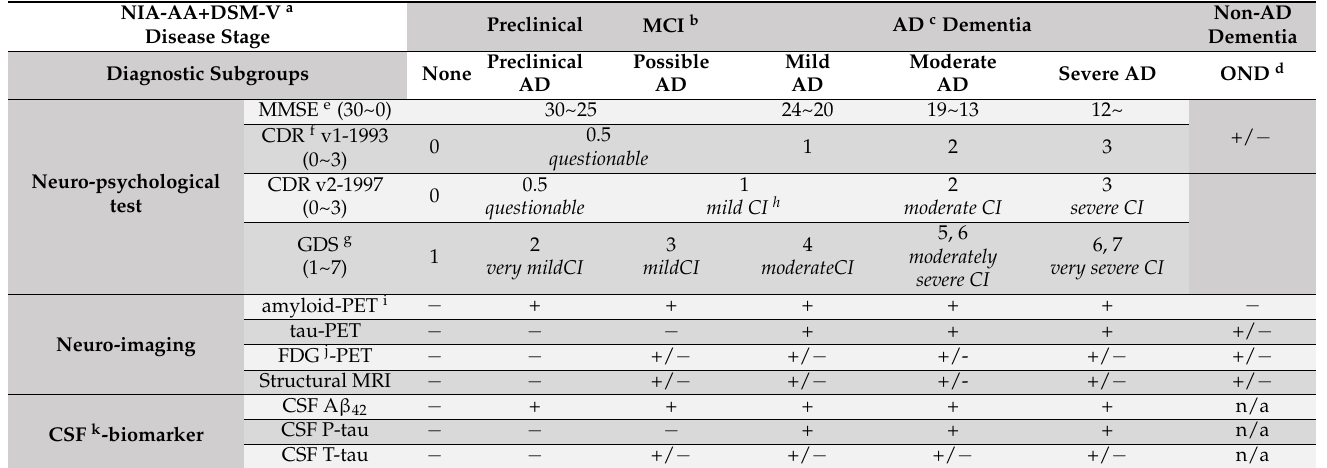
Table 2. Clinical Alzheimer’s disease